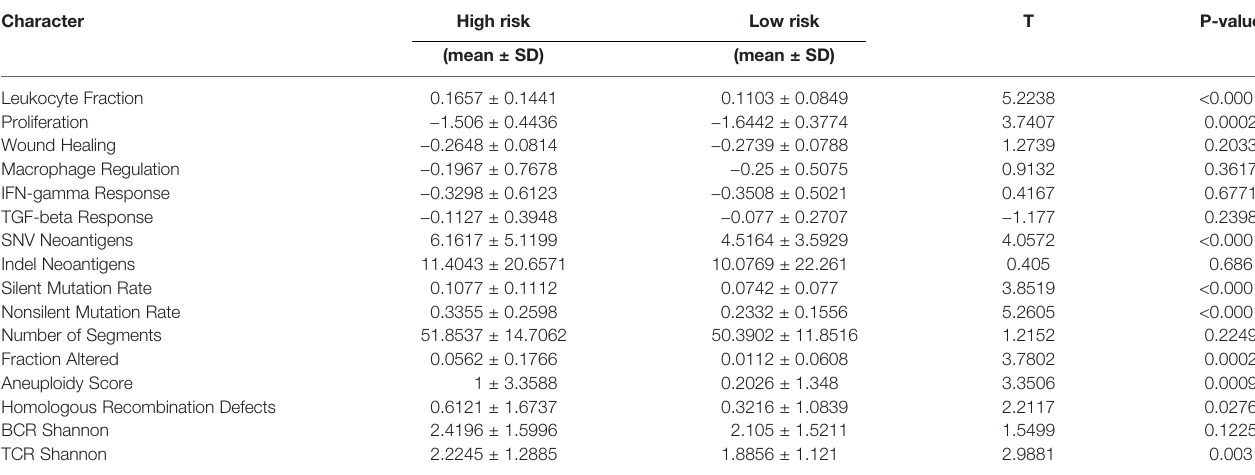
TABLE 2 | Gene set score characteristics of different prognostic risk